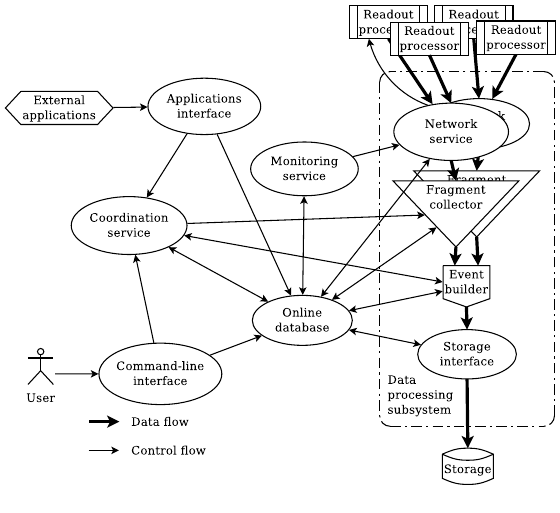
Figure 6. DAQ software